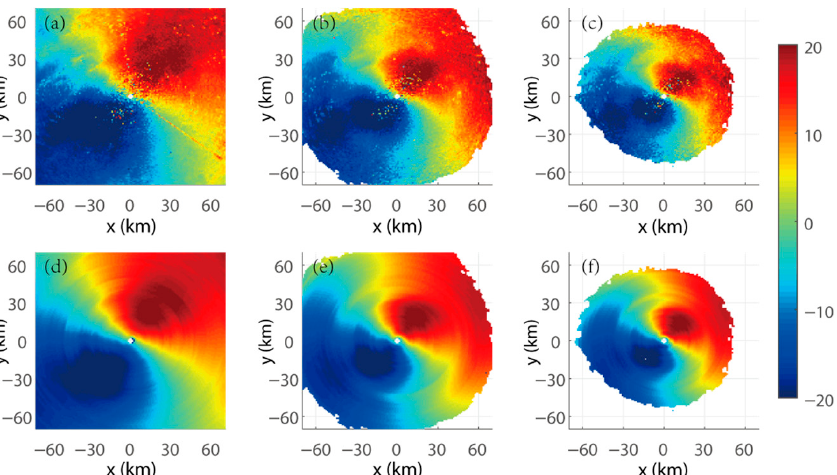
Figure 11. Doppler velocity fields ( a – c ) and the fields which were obtained from the VAD analysis ( d – f ). The elevation angles of ( a – c ) are 0.5°, 1.5°, and 2.4°, respectively, the same as ( d – f ). Except for some error points and point targets, the velocity fields ( d – f ) which were obtained from the VAD analysis are similar to the Doppler velocity ( a – c ).